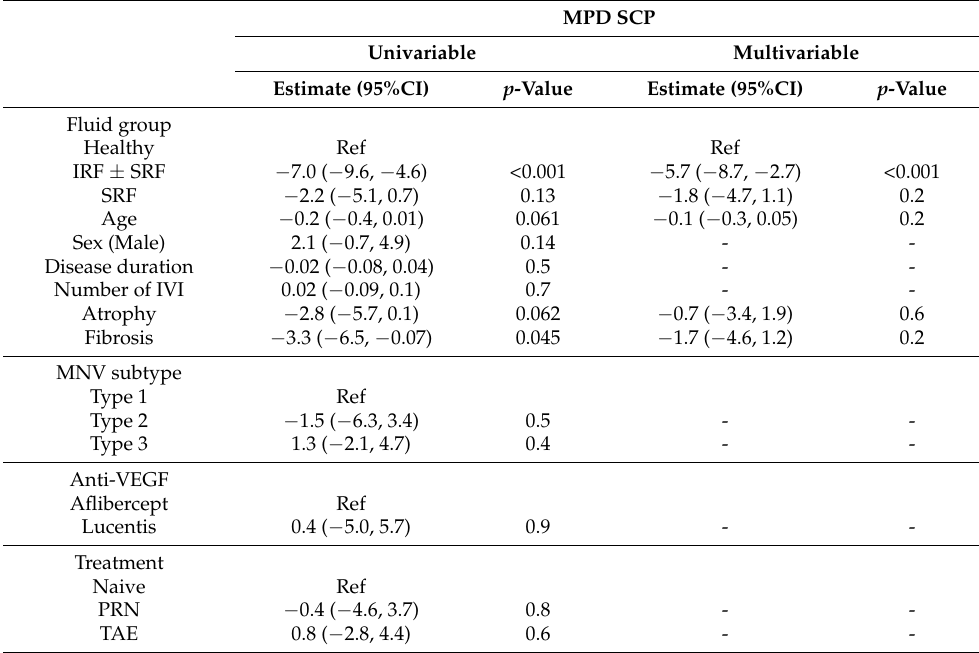
Table 2. Mean perfusion density (MPD) in the superficial capillary plexus (SCP) according to different factors in the univariate and multivariate analyses.